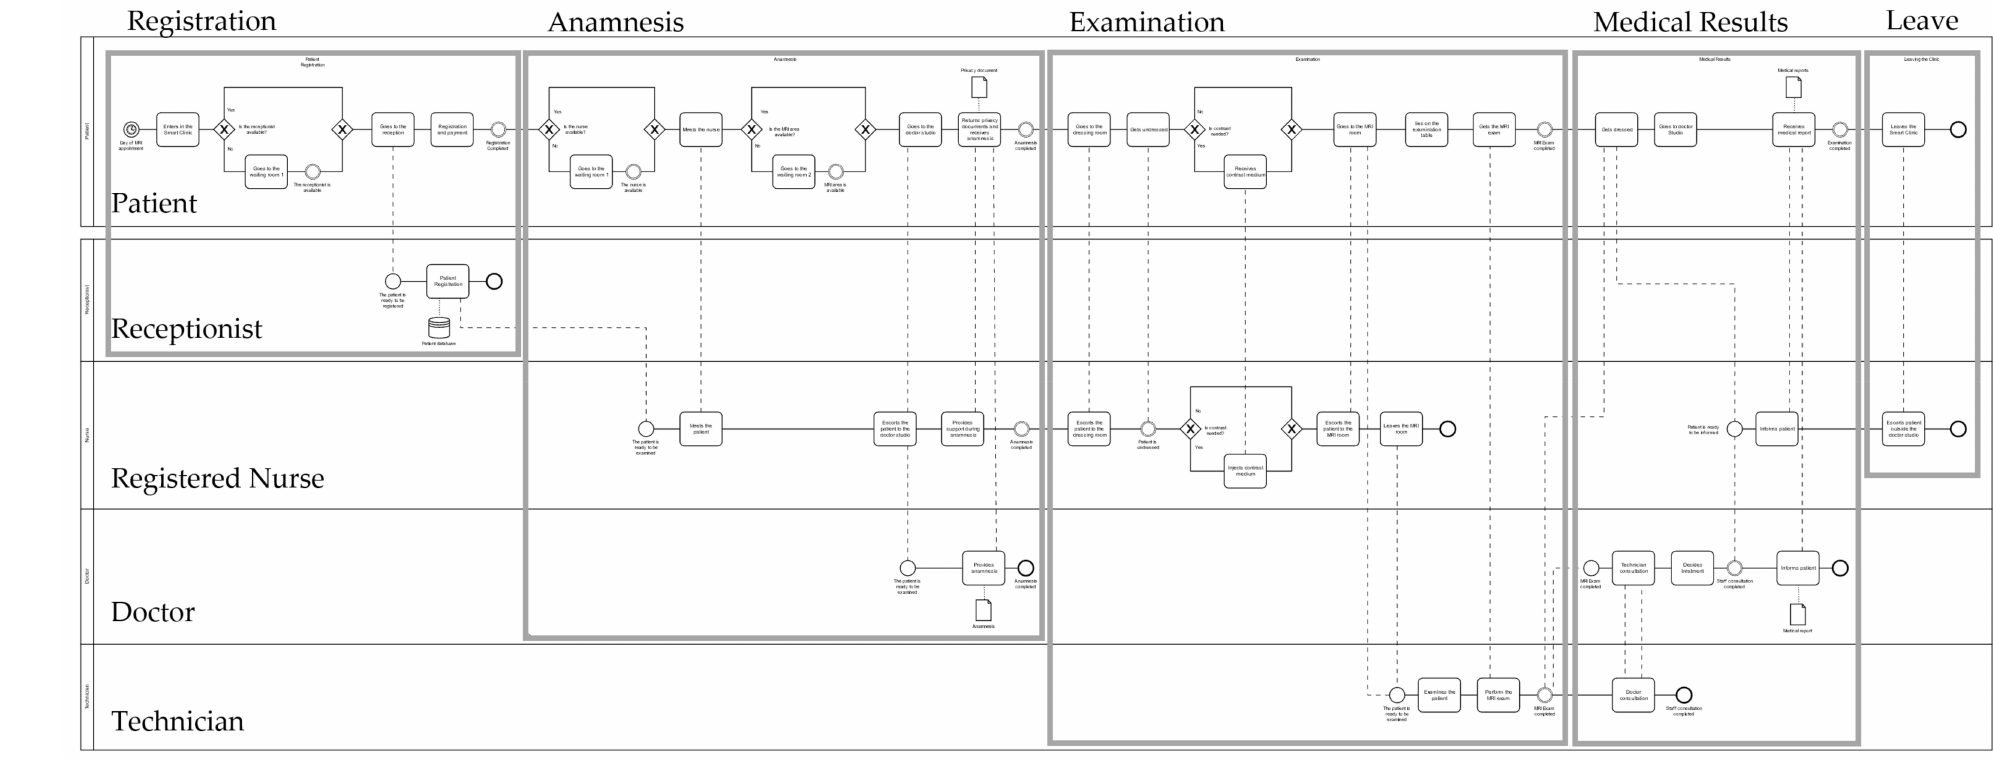
Figure 1. MRI examination